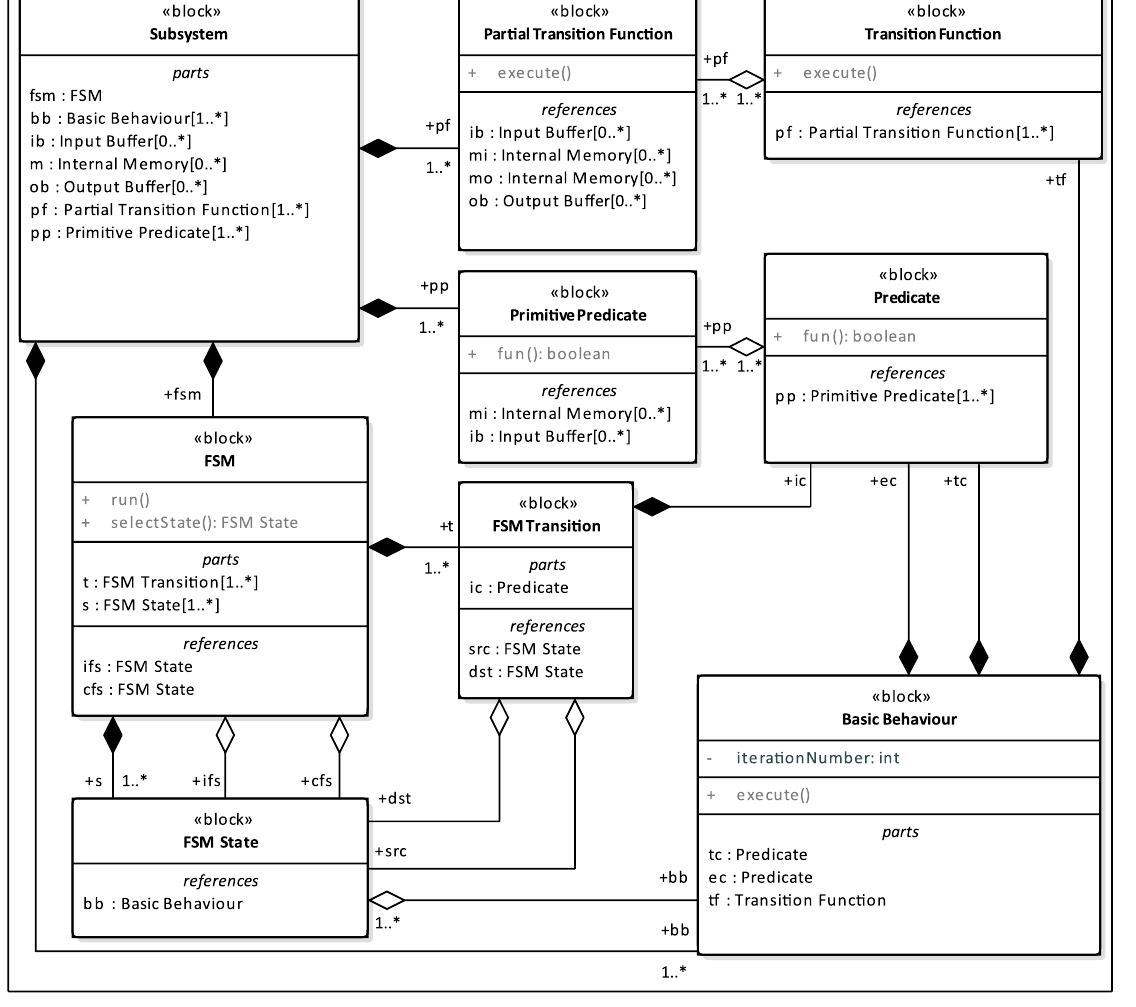
Figure 3. Subsystem and its parts (Input, Output Buffers and Internal Memory are